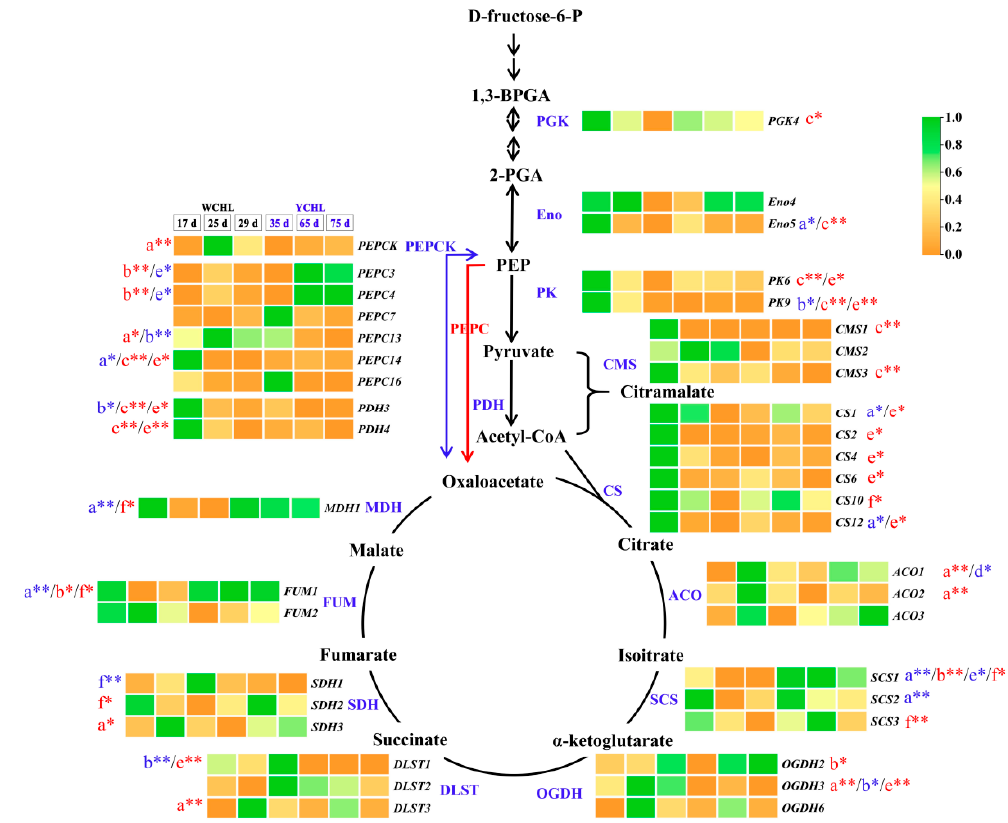
Figure 9. The proposed TCA cycle pathways in yellow pitaya and transcript abundance of their genes in ‘WCHL’ and ‘YCHL’ pitayas. Gene abbreviations are shown in Table S9. Letters a-f represent malic, citric, citromalic, oxalic acid, fumaric, and succinic acids, respectively. The correlation analyses of organic acid contents and gene expressions are labeled as * ( p < 0.05, two-tailed) or ** ( p < 0.01, two-tailed), red indicates positive relationship while blue is